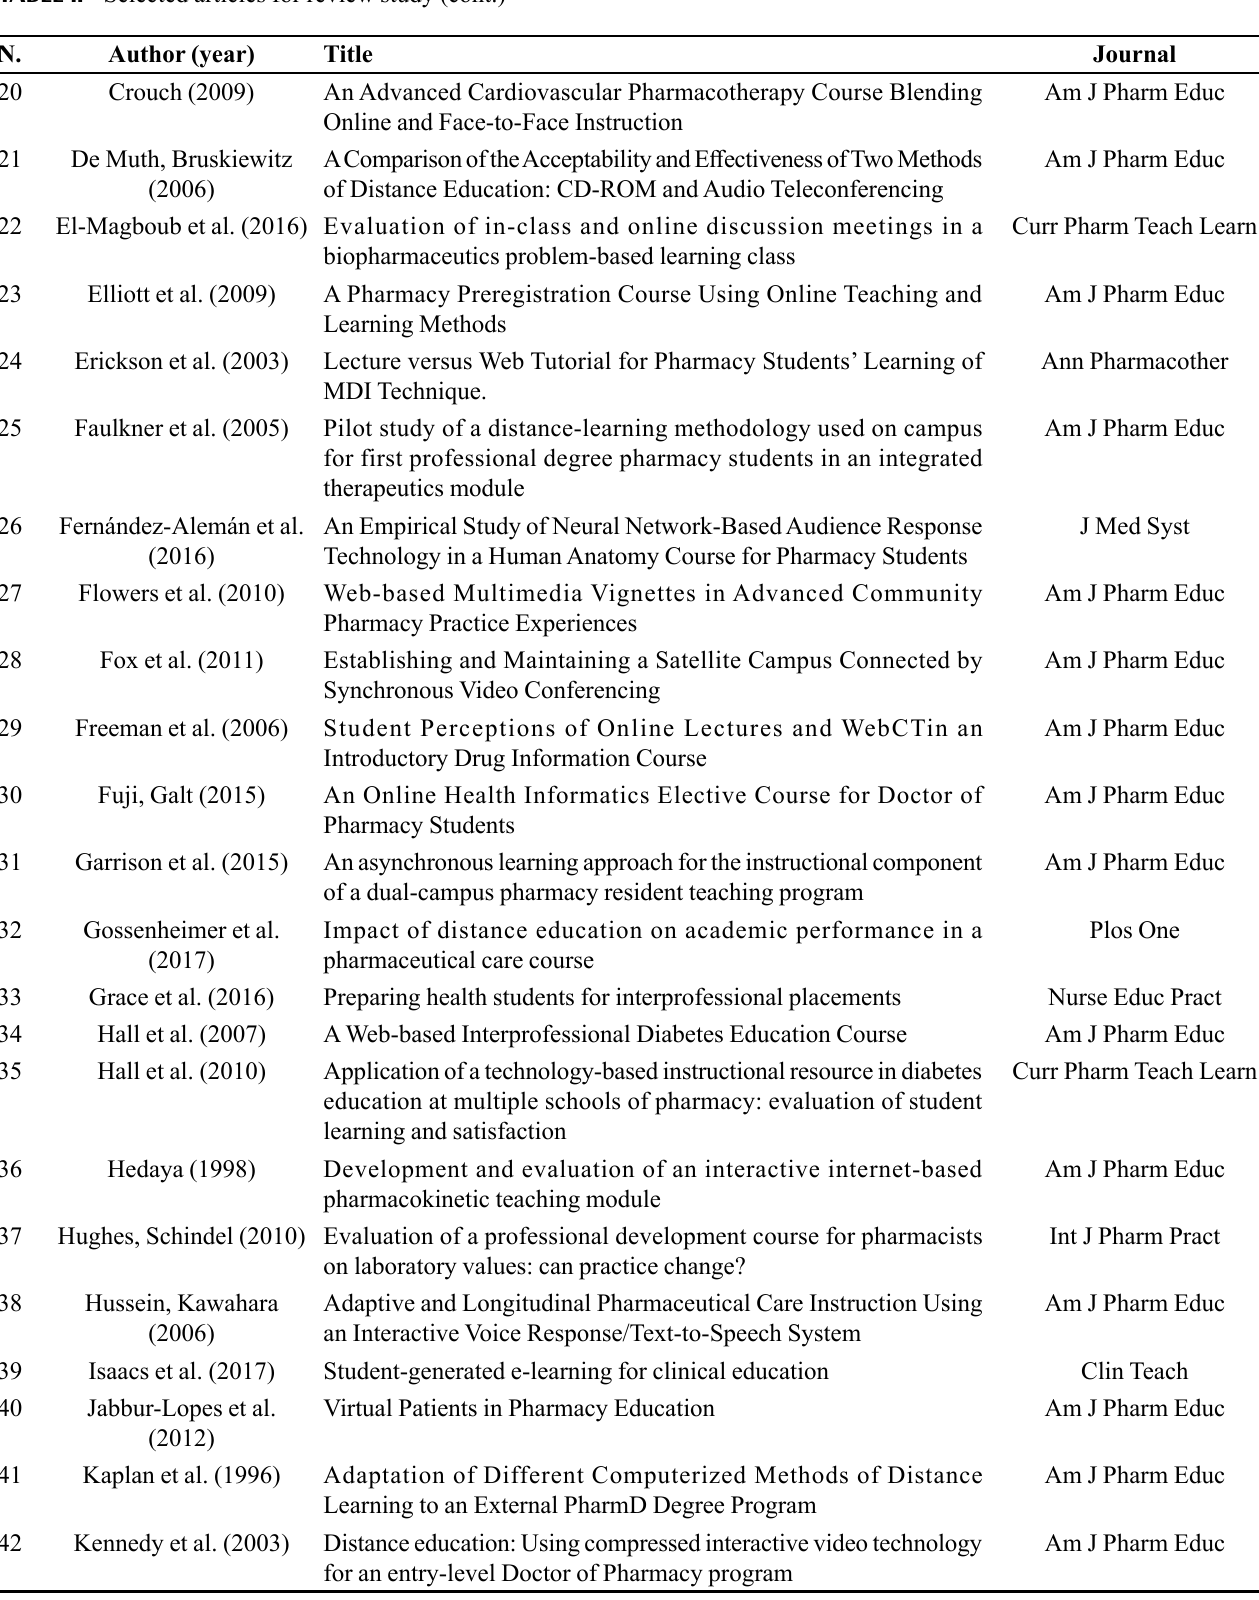
TABLE II - Selected articles for review study